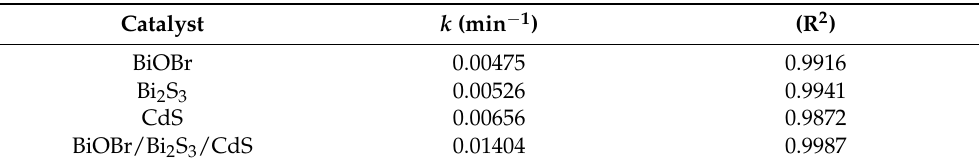
Table 1. Rate constants and correlation coefficients of MeB photocatalytic degradation by BiOBr, Bi 2 S 3 , CdS and BiOBr/Bi 2 S 3 /CdS.